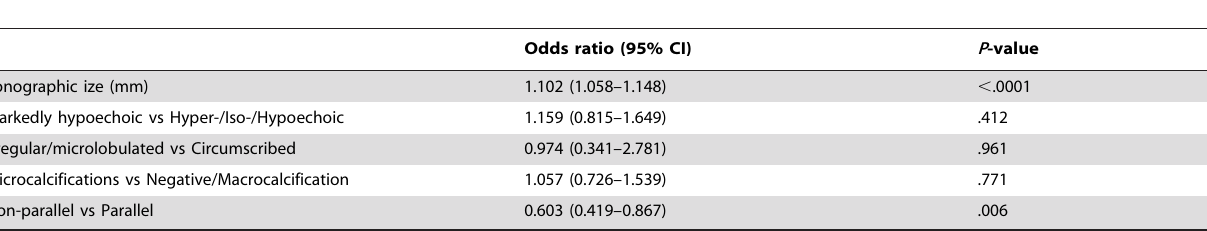
Table 2. Multivariate analysis of the association of the BRAF V600E mutation with sonographic features in patients with PTC.